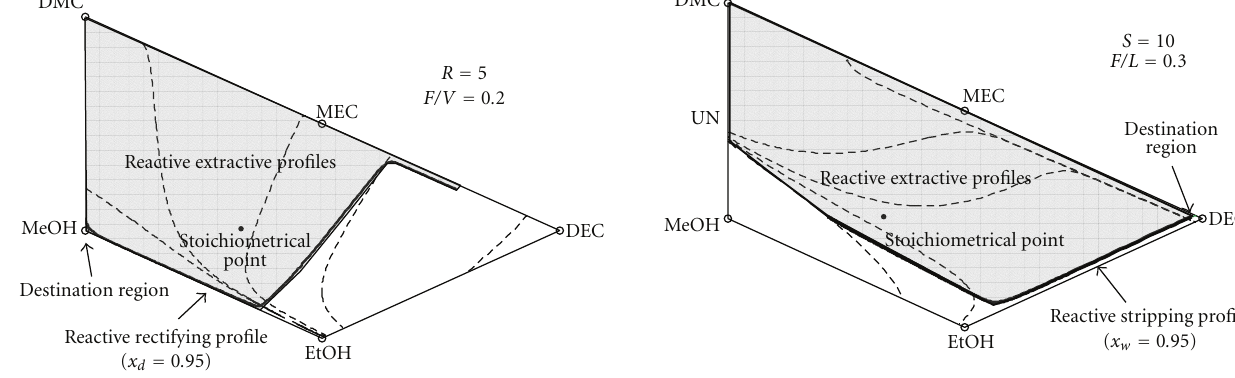
Figure 6: Rectifying profiles with finite reflux ratios.